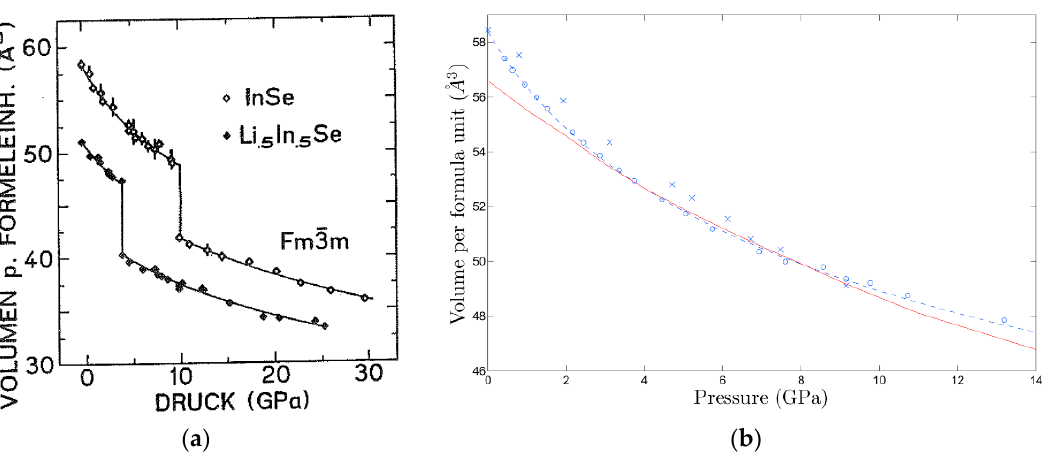
Figure 2. Results of XRD experiments in InSe-I DAC: ( a ) EOS of InSe-I and InSe-II from powder diffraction. The x- axis corresponds to the pressure and the y –axis to the volume per formula [27]. ( b ) EOS of of InSe-I from single crystal diffraction (circles). Crosses represent the data of Figure 1a [29]. Results of X-ray absorption (XAS) [31] in DAC, using γ -InSe single crystals, added relevant